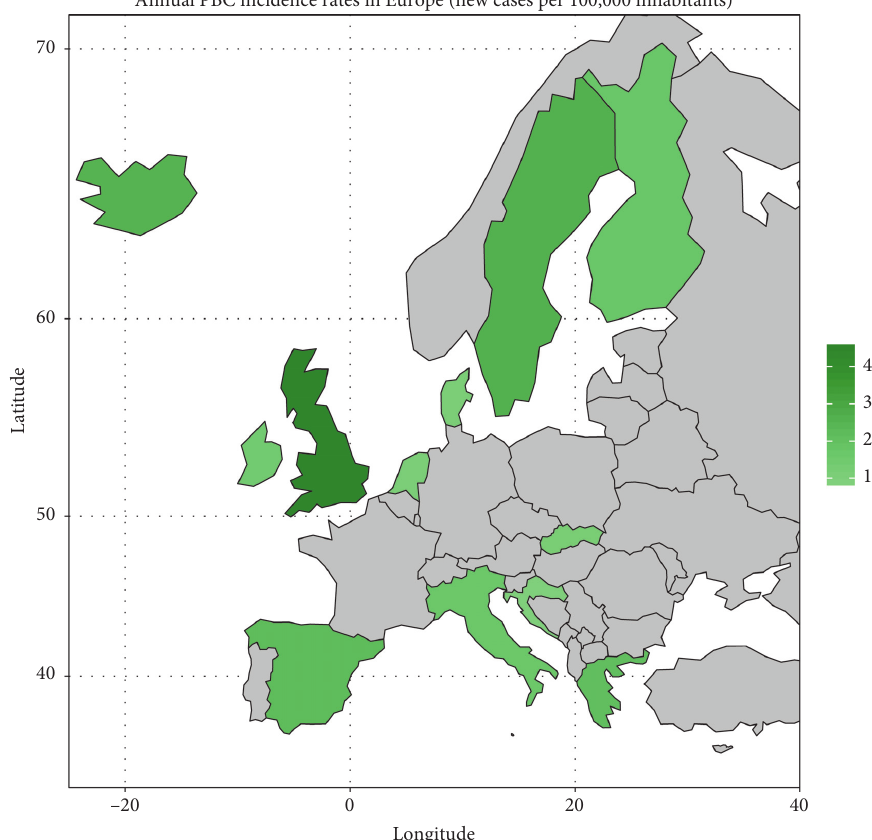
Figure 7: Choropleth map of annual PBC incidence rates in Europe.